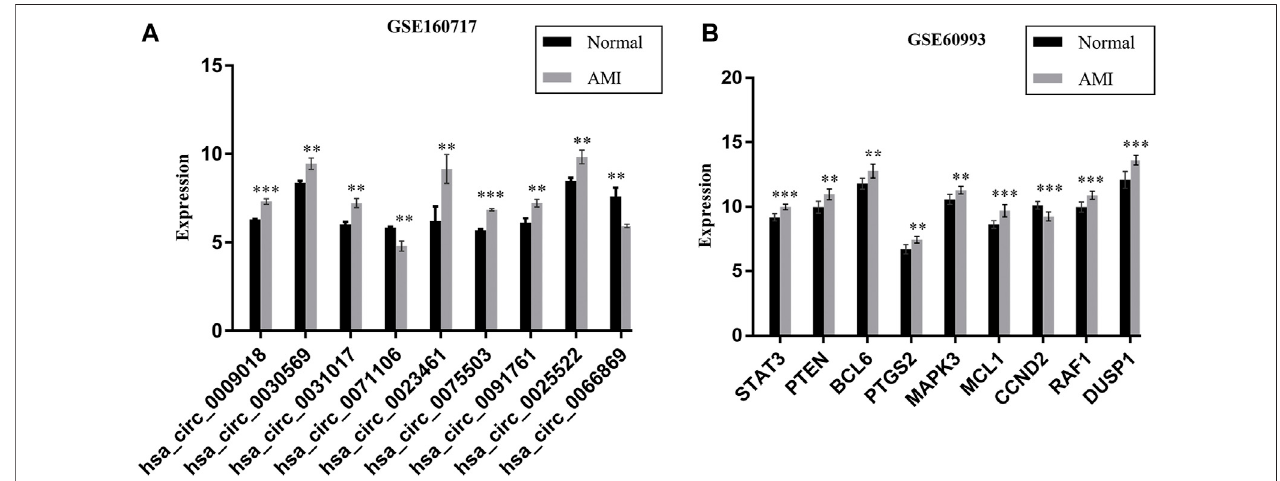
FIGURE7| Theexpressionof9DEcircRNAs (A) and9hubgenes (B) inAMIandnormalcontrols,datacomesfromGSE160717andGSE60993.** p < 0.01;*** p < 0.001.